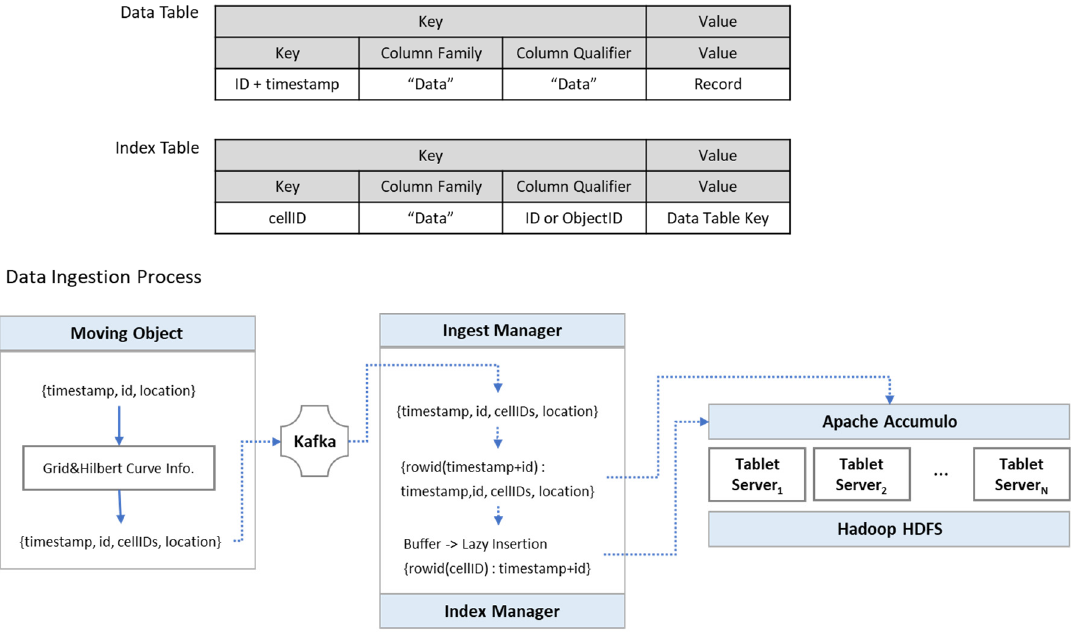
Figure 4. Data ingestion process and schemas for the index and data table.